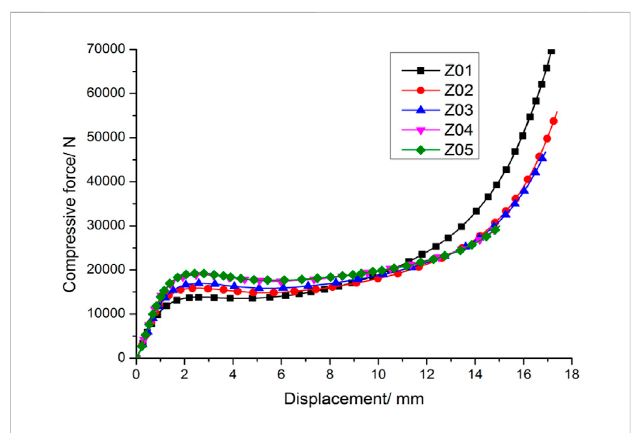
Compressive force-displacement curves at different loading rates.